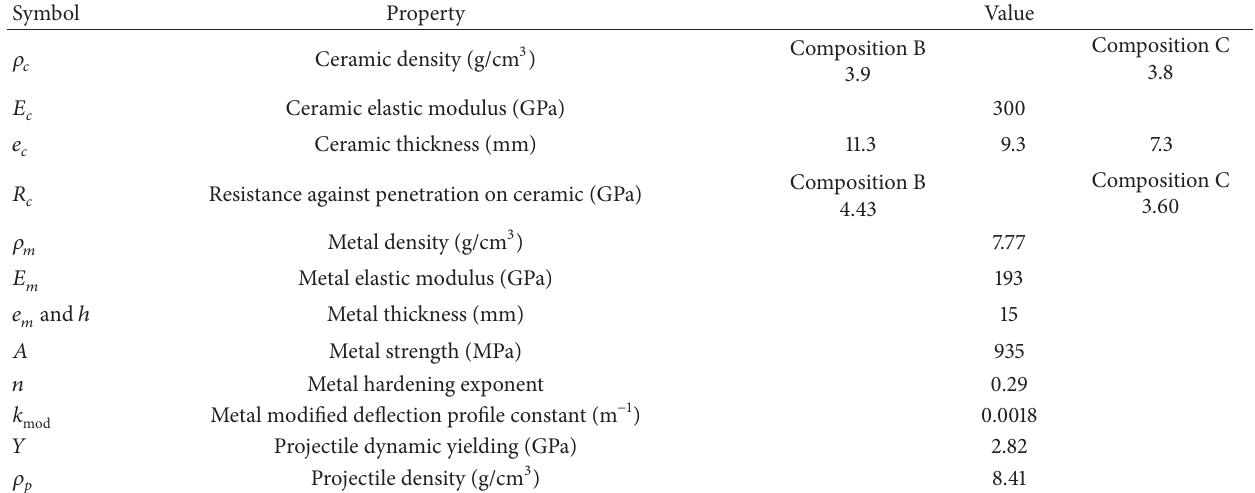
Table 5: Values of the constants used in the modified model.